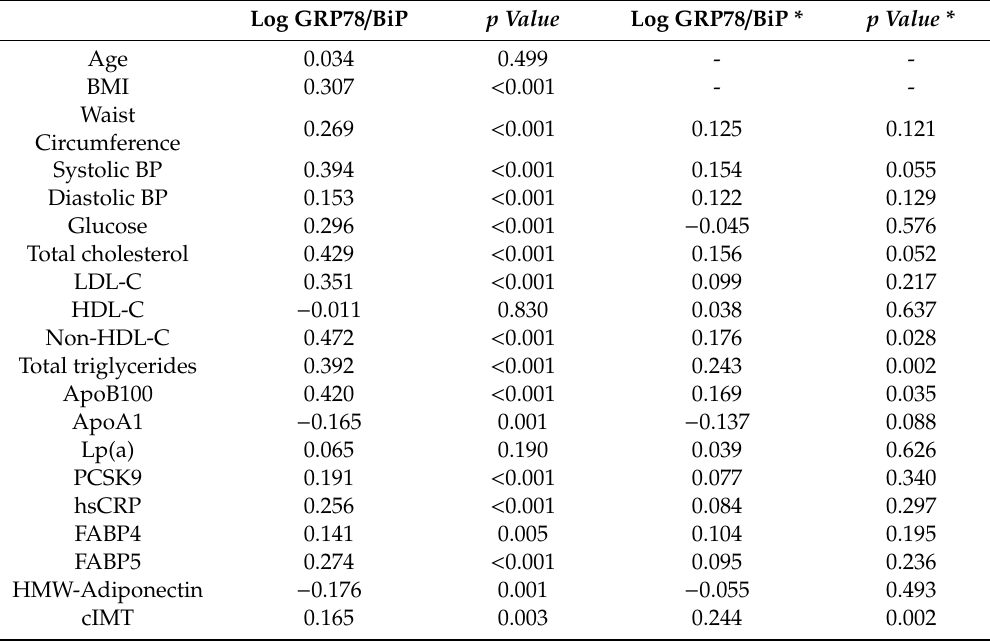
Table 2. Relationships between log-GRP78 / BiP and continuous